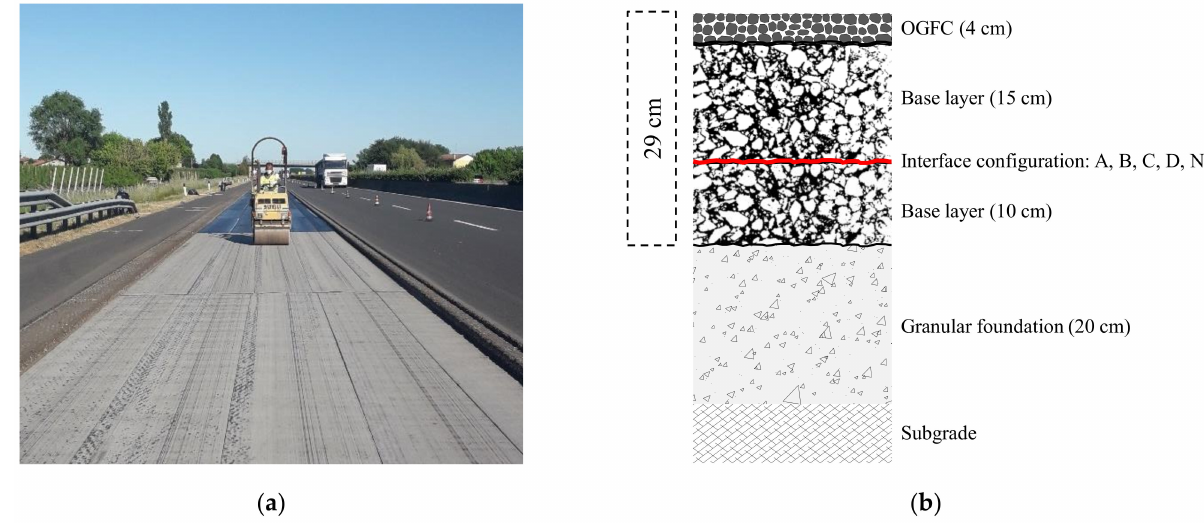
Figure 5. Trial section: construction phases ( a ), stratigraphy ( b ). The trial section included five consecutive test fields with a length of 100 m each: one reference test field without any reinforcement (coded as N) and four test fields with the geocomposites A, B, C and D (the same ones included in the laboratory investigation).